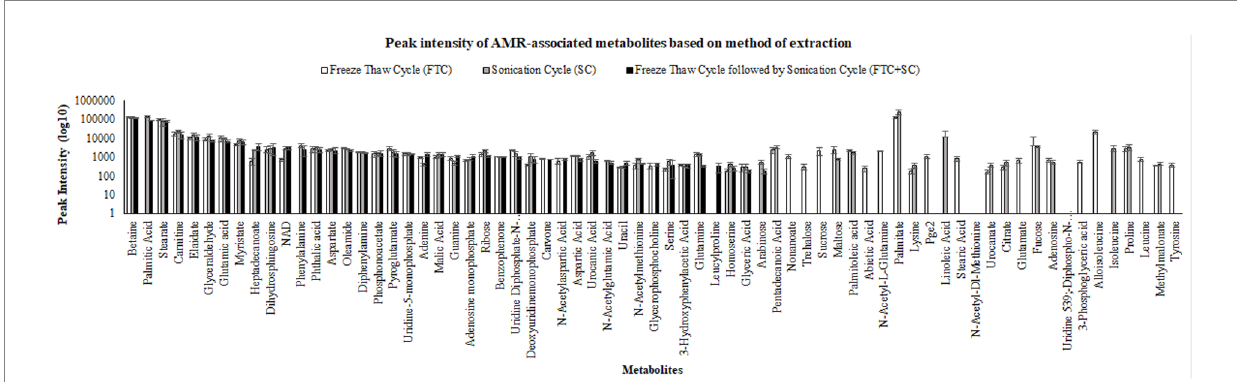
FIGURE 4 Pictorial representation of peak intensities of identified metabolites (selected using one-way ANOVA, means ± SD, with cutoff value of p ≤ 0.05) using three different metabolite extraction methods (FTC, SC and FTC + SC). The data represents the metabolites (intensity) from the n ≥ 4 (out of six independent biological replicate-Supplementary Table 1) samples. FTC, freeze-thaw cycle; SC, sonication cycle; FTC + SC, freeze-thaw cycle followed by sonication